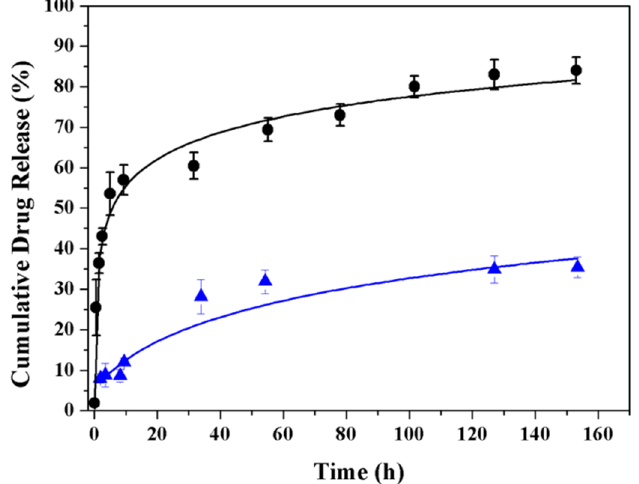
Figure 14. Release profiles in a PBS-EtOH 70% medium of the antibacterial scaffold (black) and non- porous (blue) micromolded PLA specimen. Both samples contained 6 wt-% of TCS. non-porous (blue) micromolded PLA specimen. Both samples contained 6 wt-% of